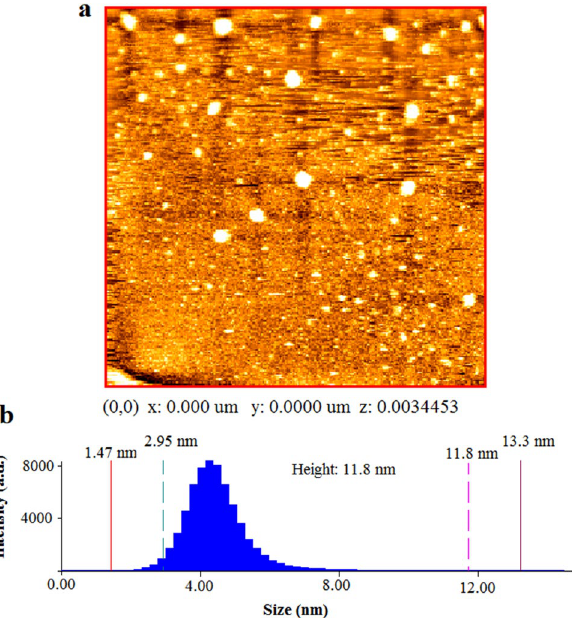
Figure 3. The AFM results of the synthesized CQDs; ( a ) AFM image of the CQDs on a cleaved mica surface, ( b ) size distribution histogram of the